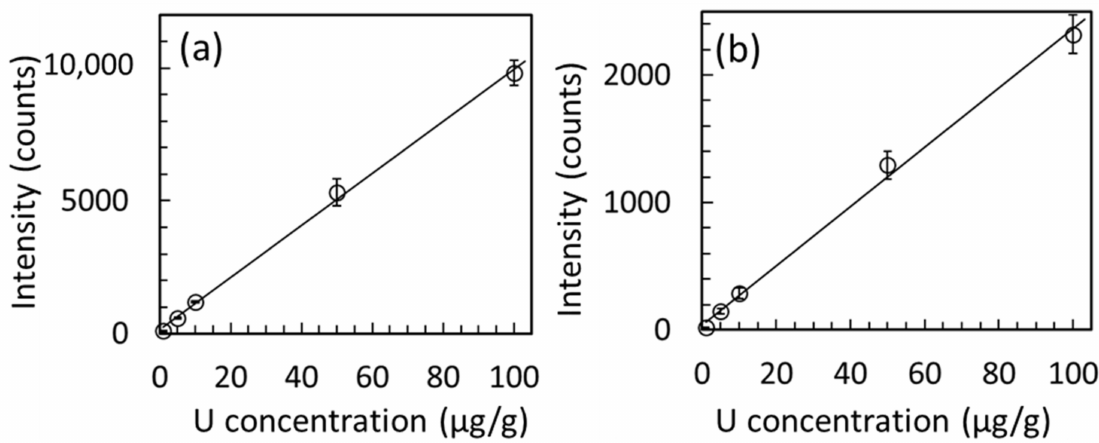
Figure 2. Calibration lines of 1–100 µ g/g U in 0.1 M HNO 3 . Horizontal axis: U concentration ( µ g/g); vertical axis: X-ray intensity in the analyzed area of ( a ) U-L α (12.8–14.2 keV) and ( b ) U-L β 1 (16.8–17.8 keV) lines. Each point represents the mean and standard deviation of data from three